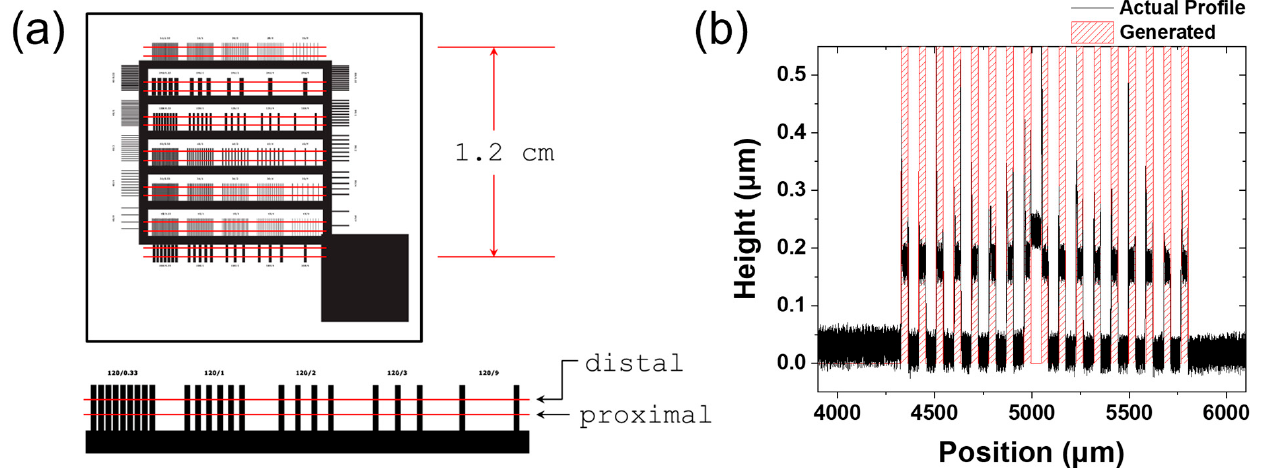
Figure 1. ( a ) (top) Full feature test pattern and (bottom) single row demonstrating the distal/proximal scans. ( b ) Actual uncoated test pattern profile (black) compared to calculated binary profile (shaded red). An error can be observed in the center of the grating that has been corrected in the model.